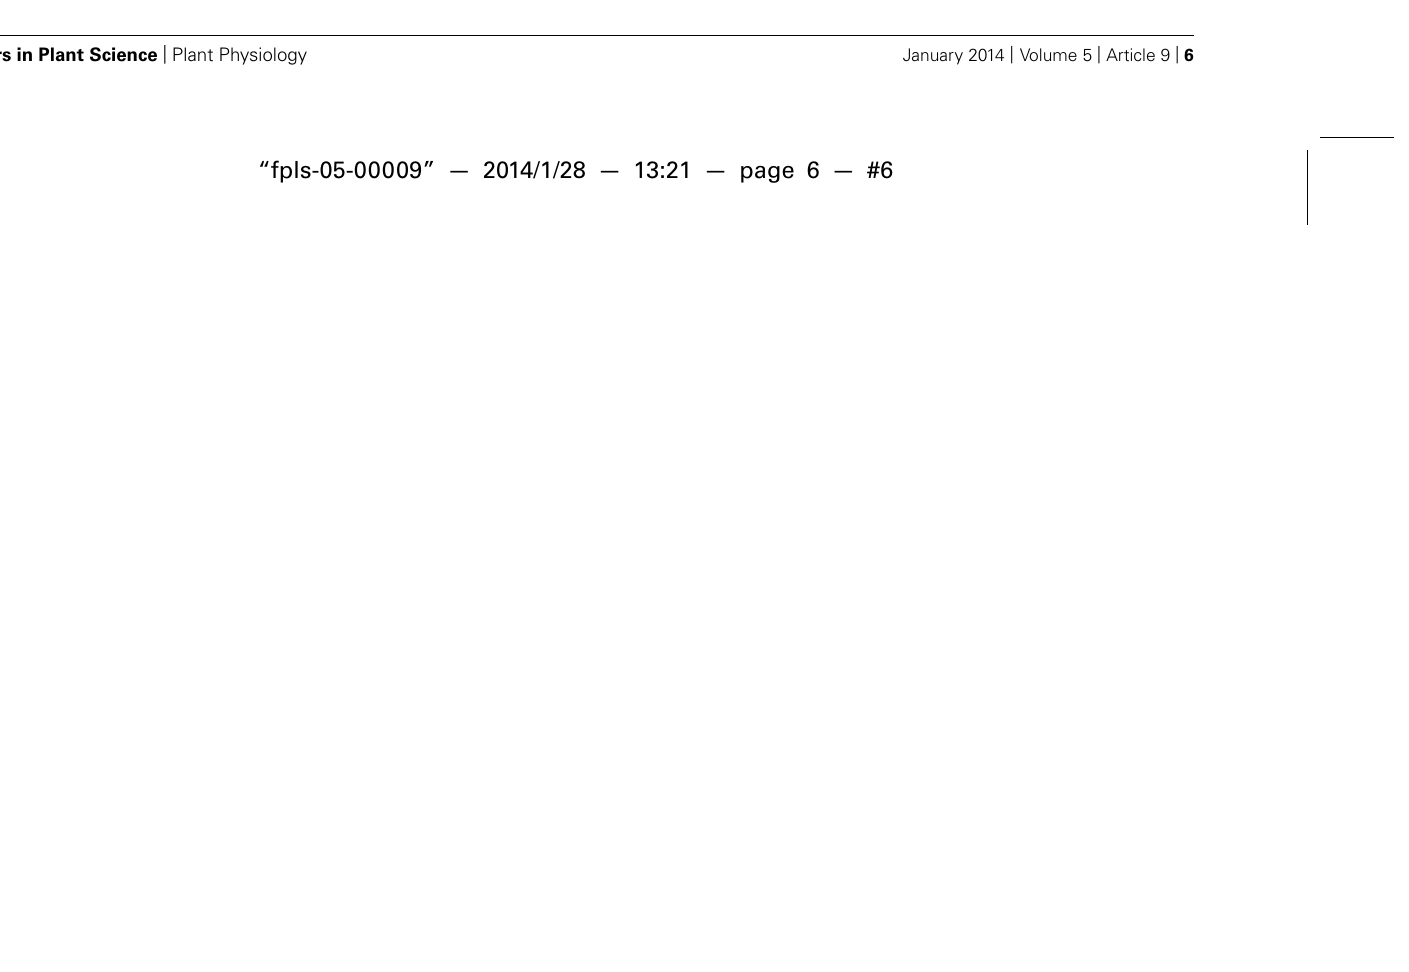
FIGURE 3 | Co-expression analysis of the CP12 gene family using the Arabidopsis thaliana trans-factor and cis-element prediction database, ATTED-II (produced 15/11/2013). Co-expressed gene network around (A) CP12-1 (http://atted.jp/data/locus/819353.shtml). (B) CP12-2 (http://atted.jp/data/locus/825414.shtml) and (C ) CP12-3